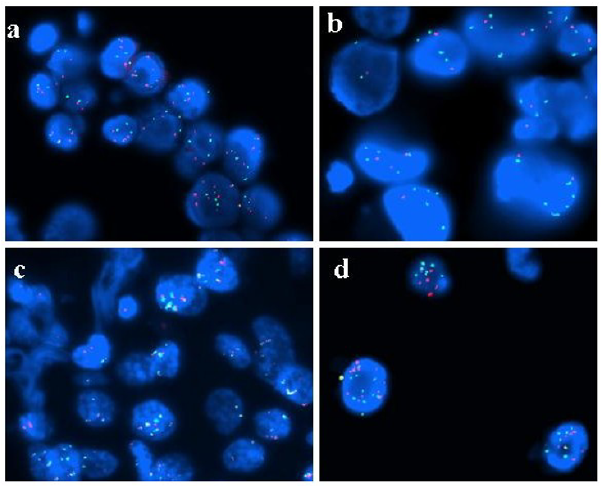
Figure 2 FISH analysis of 7q31 region . Case n° 10: a) FISH in bron- chial biopsy section showing gain of both EGFR gene and chromosome 7 centromere; b) the patient is classified as amplified on the basis of eusomic status of 7q31 region. Case n° 2: c) FISH in pleural effusion sample with EGFR and cen- tromere balanced aneusomy; d) increased copy number of 7q31 region is a signature of